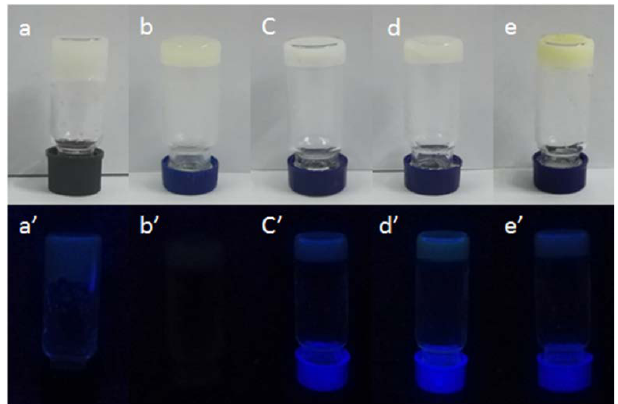
Figure 1. Imagines of gel 1 formed in different solvents: ( a , a’ ) DMF, ( b , b’ ) DMSO, ( c , c’ ) acetone, ( d , d’ ) 1,4-dioxane, ( e , e’ ) ethanol. The upper and lower were under daylight and 365 nm light, re- spectively.